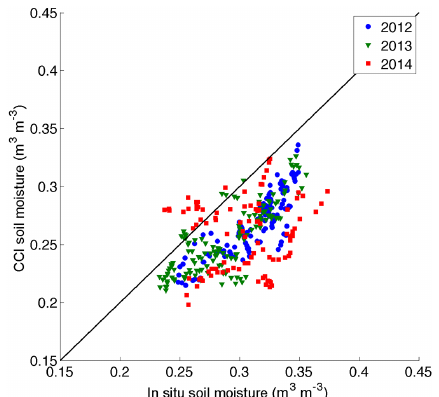
Figure 13. Scatter plot of weekly running average top soil layer ESA CCI soil moisture data product estimate comparison against weekly running average spatially weighted areal average in situ ob- servations for the years 2012, 2013, and